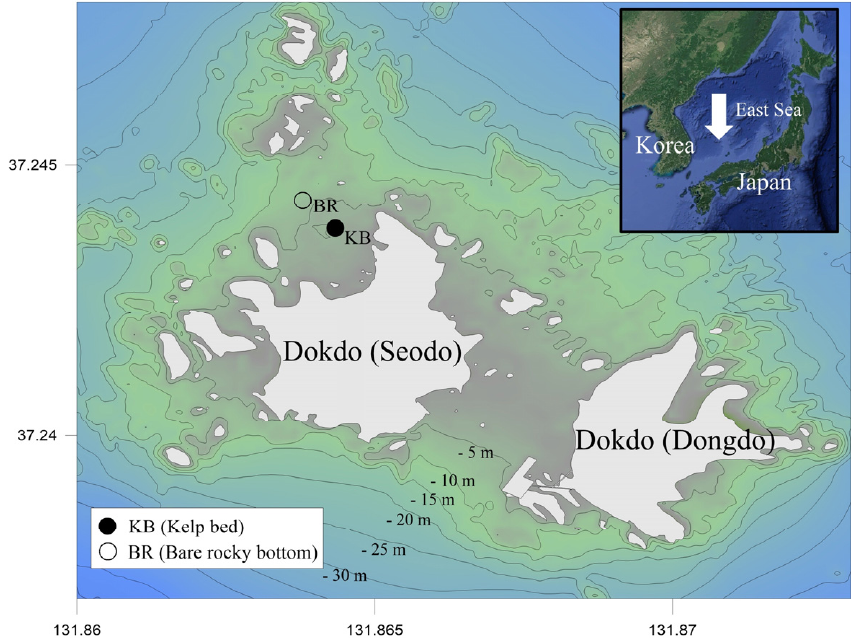
Figure 1. Map showing the sampling stations. The solid circle is the kelp bed ( Ecklonia cava and Eisenia bicyclis ) and the open circle is the bare rocky bottom (BR).